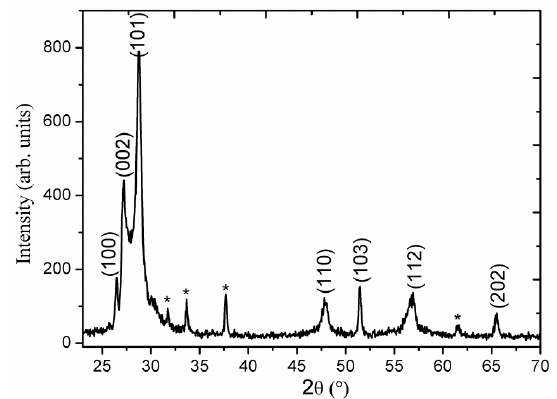
Figure 1. X-ray diffraction (XRD) of ZnS nanoclusters comprised on nanowires.